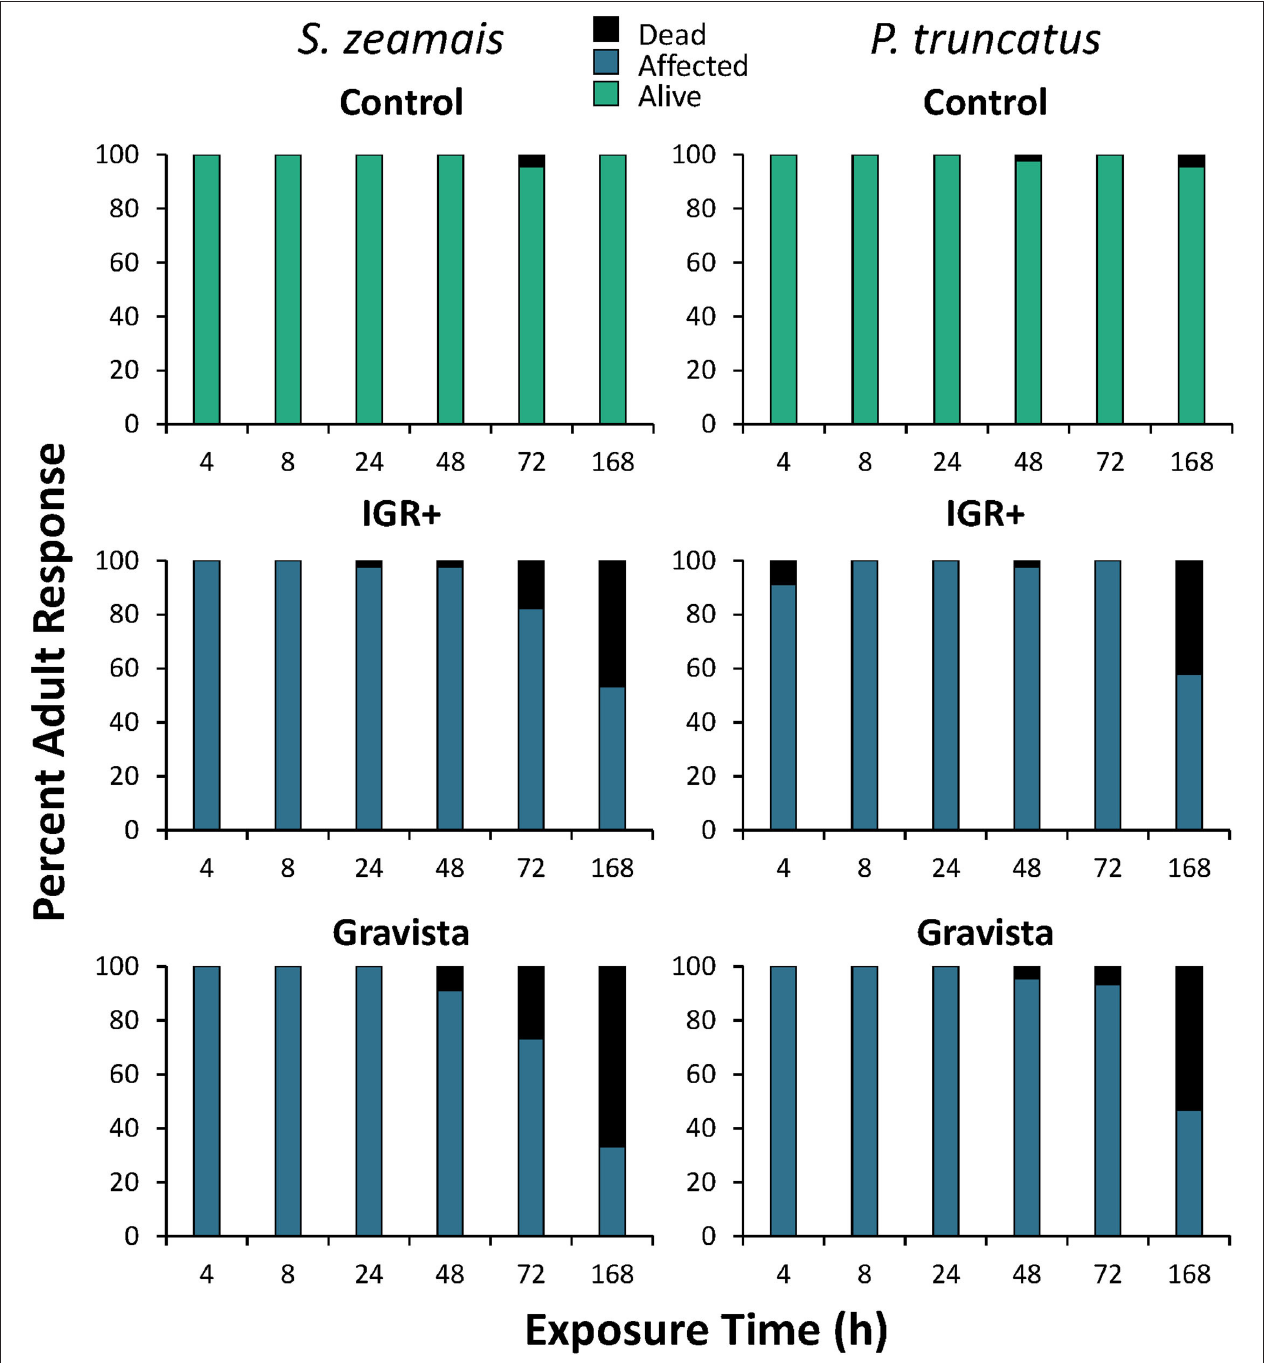
FIGURE 6 | Percent mortality induced by an existing (methoprene + deltamethrin, IGR + ) and novel (methoprene + deltamethrin + synergist, Gravista) commercial formulation of insecticide when applied against S. zeamais (left column) and P. truncatus (right column) on maize broken down by exposure time, resulting in alive (green), affected (blue), or dead (black) individuals.